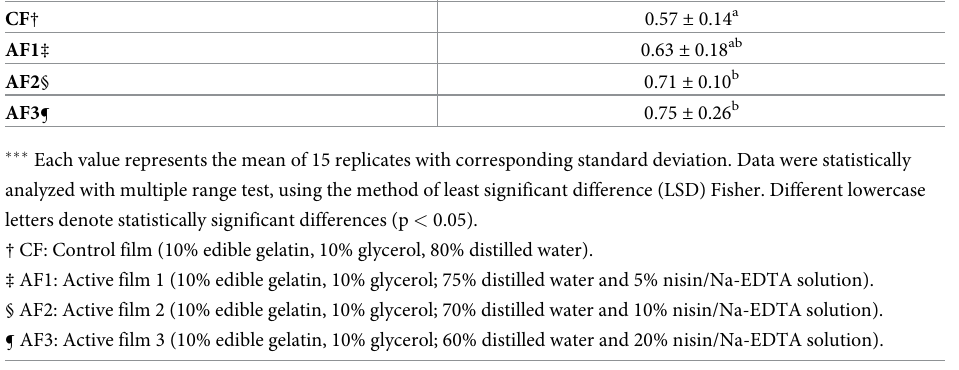
Table 3. Determination of thickness of the films. ���